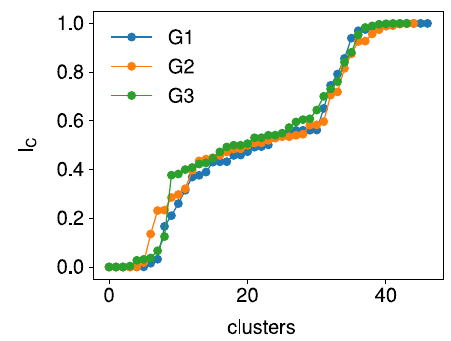
Fig. 3 Average proportion of incoming edges per